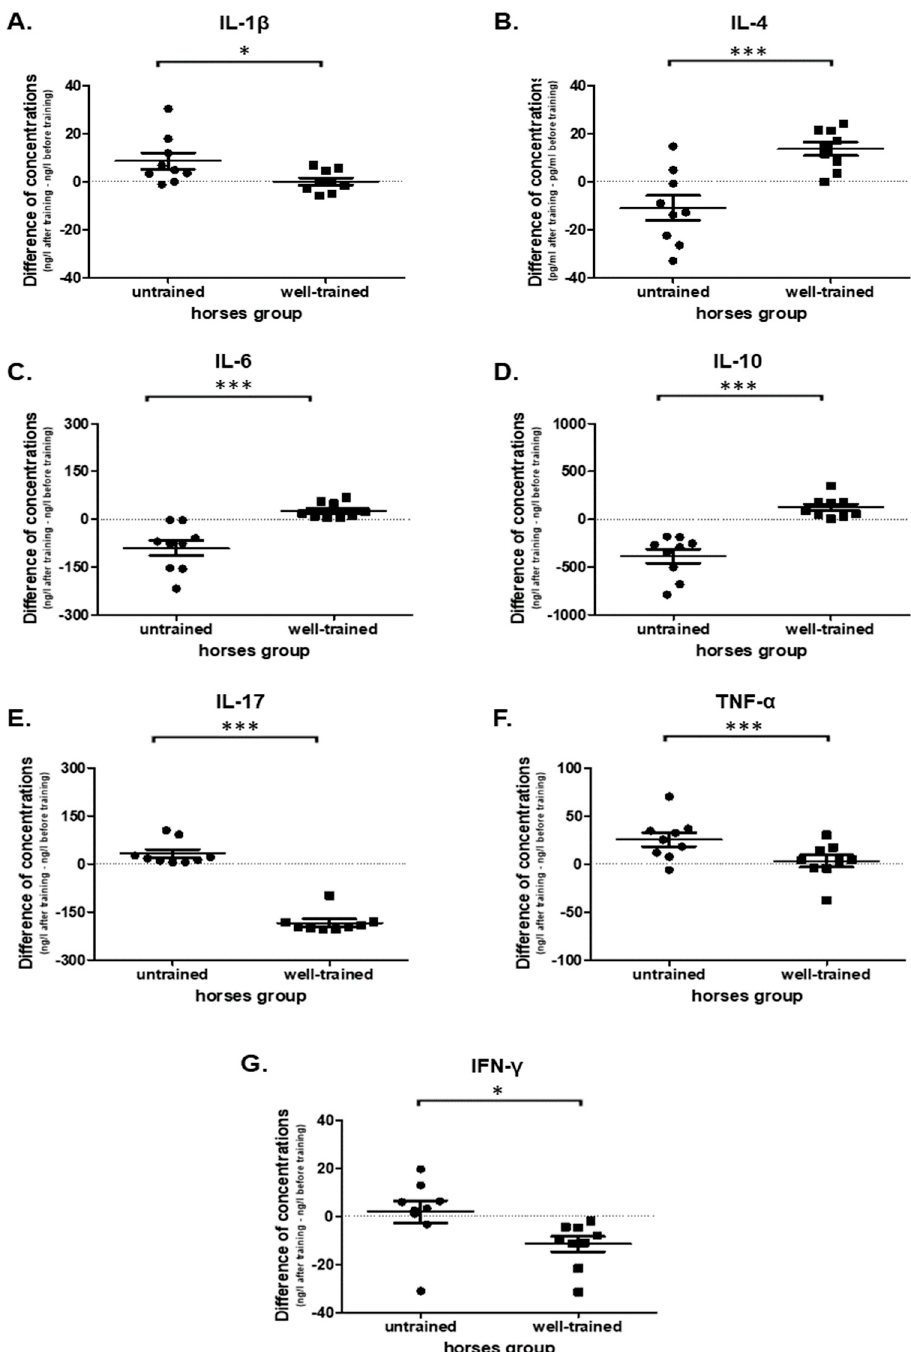
Figure 6. Graphic representation showing the cytokine concentrations: IL-1 β ( A ), IL-4 ( B ), IL-6 ( C ), IL-10 ( D ), IL-17 ( E ), TNF- α ( F ), and IFN- γ ( G ) presented in culture medium of PBMCs obtained from untrained and well-trained horses. The results are presented as the mean ± SEM. Significance levels are: * p < 0.05; *** p < 0.001.